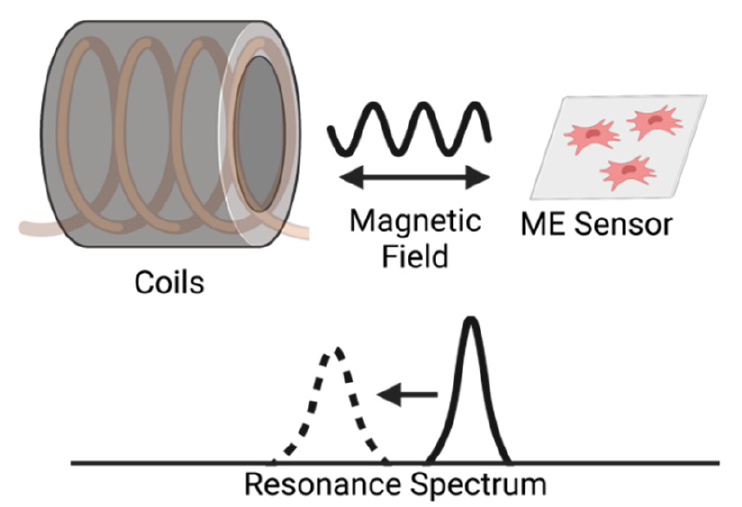
Figure 1. Illustration of the detection of a magnetoelastic sensor by measuring the change in its resonance spectrum. The magnetoelastic sensor and detection coil are inductively coupled, which records the sensor’s resonance spectrum by measuring the coil’s impedance spectrum. Magnetic sensing techniques are not limited to the detection of biologics based on mechanical resonance due to mass loading. For instance, Quandt et al. reported a mag- netoelectric sensor based on composite magnetoelastic and piezoelectric thin films with detection limits as low as 2.6 pT/Hz 1/2 [14,15]. These results would suggest that